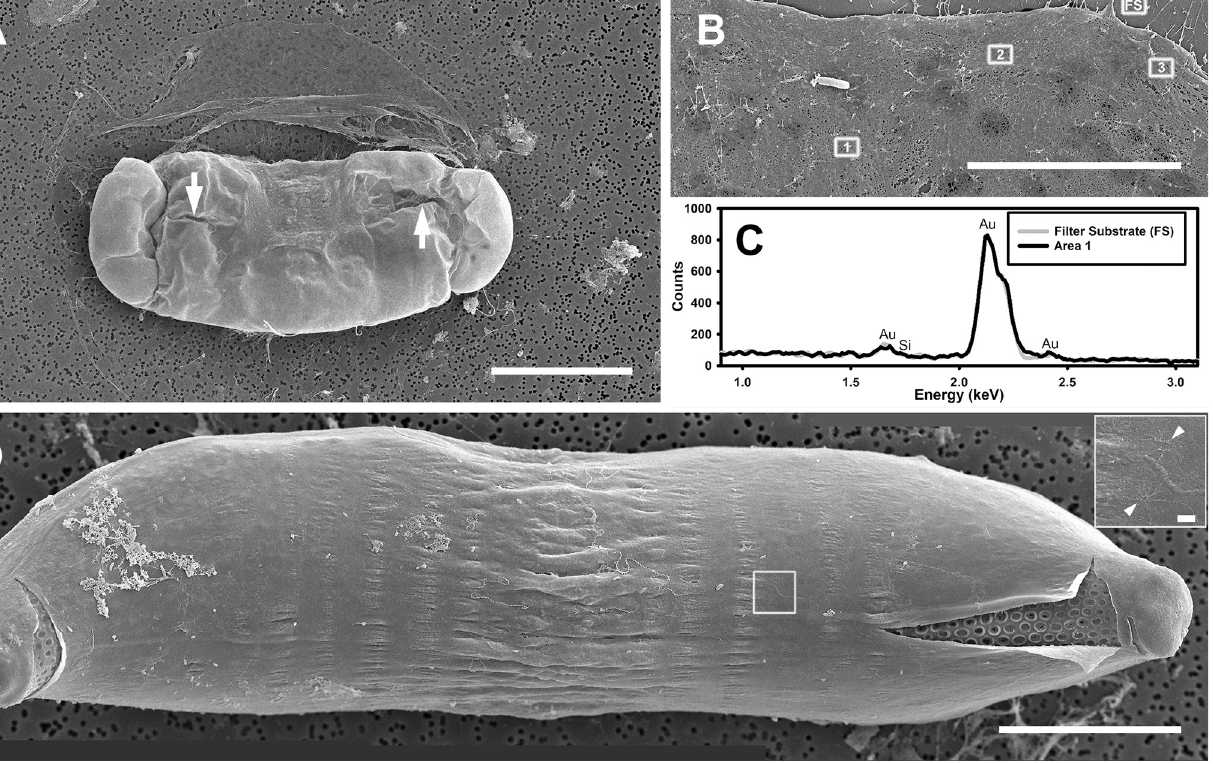
PLOS ONE | https://doi.org/10.1371/journal.pone.0272778 September 6,